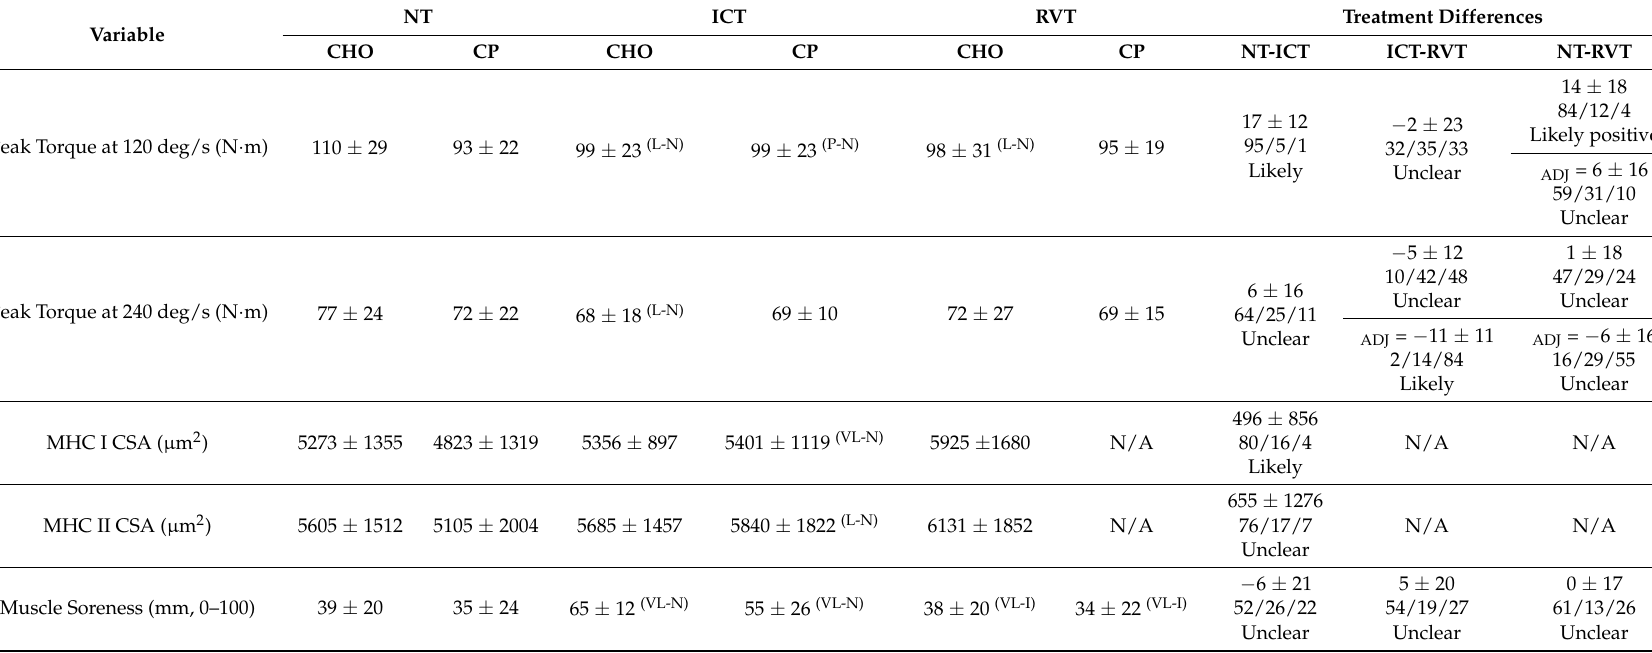
Table 4. Muscle Fiber Size (Mean ± SD) following Normal, Intensified, and Reduced-Volume